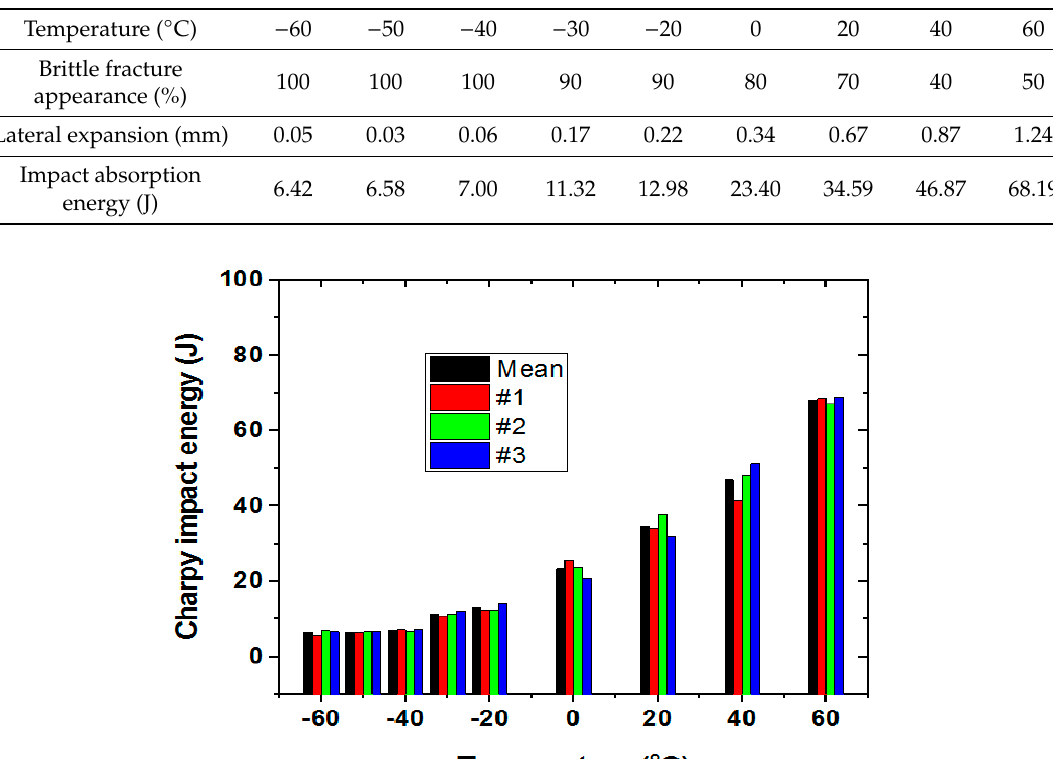
Table 4. Charpy impact test results.